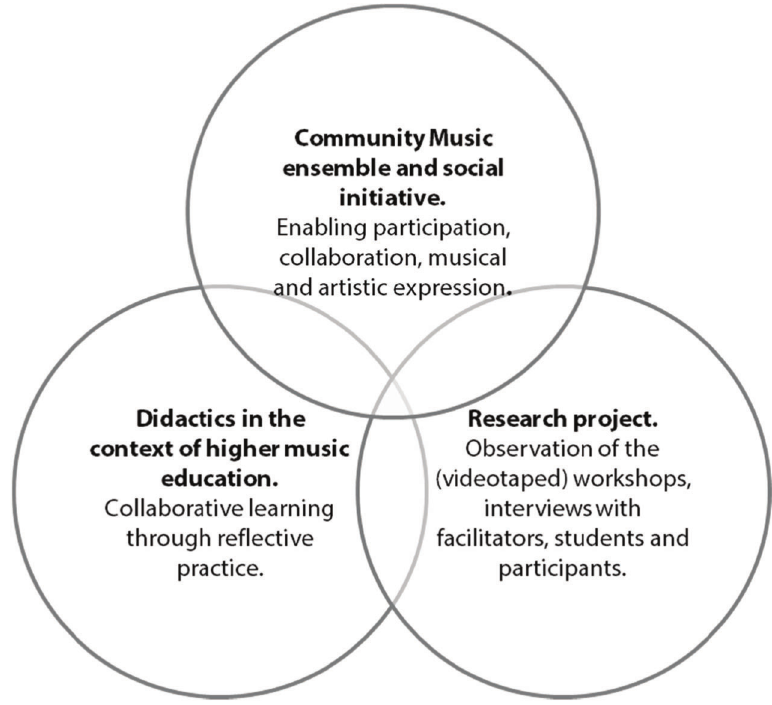
Figure 1: Dimensions of